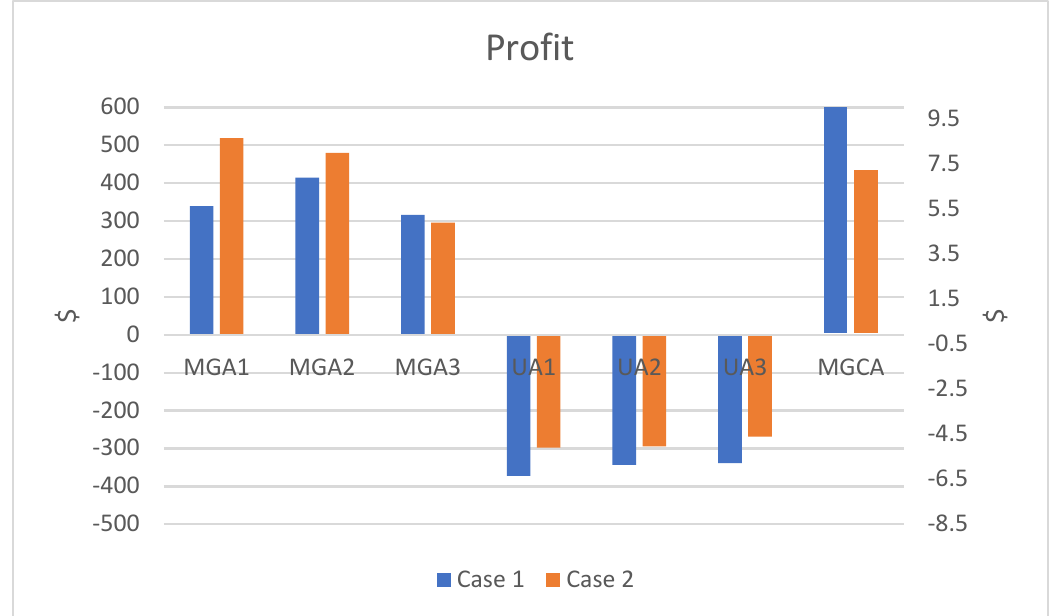
Figure 18. The profit of each microgrid and the microgrid cluster.